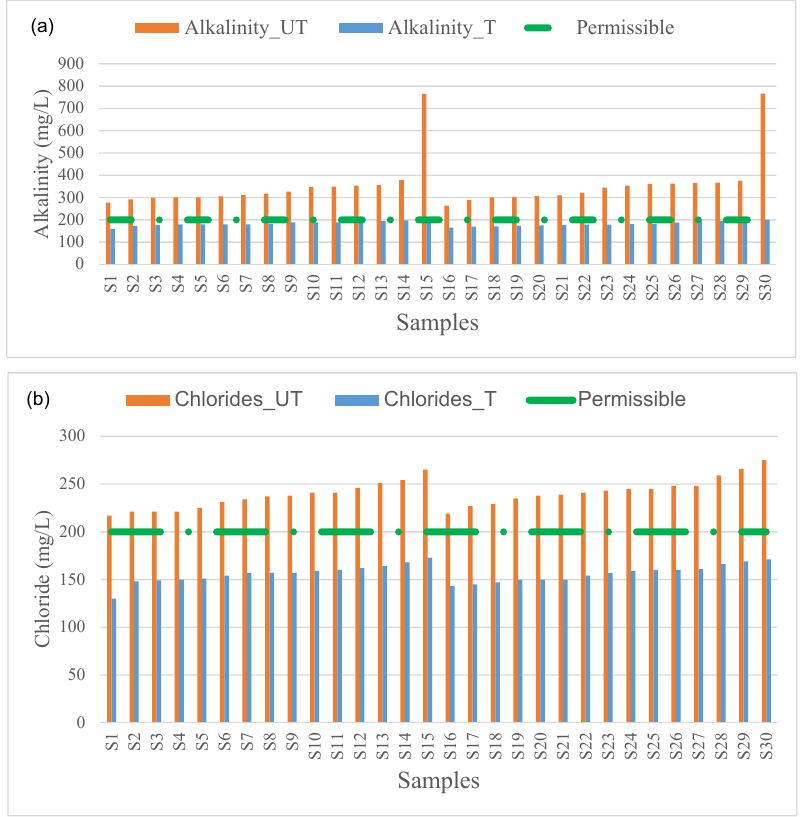
Figure 6. Alkalinity ( a ) and chlorides ( b ) of untreated (UT) and treated (T) samples and permissible limits. Appl. Syst. Innov. 2021 , 4 , x FOR PEER REVIEW